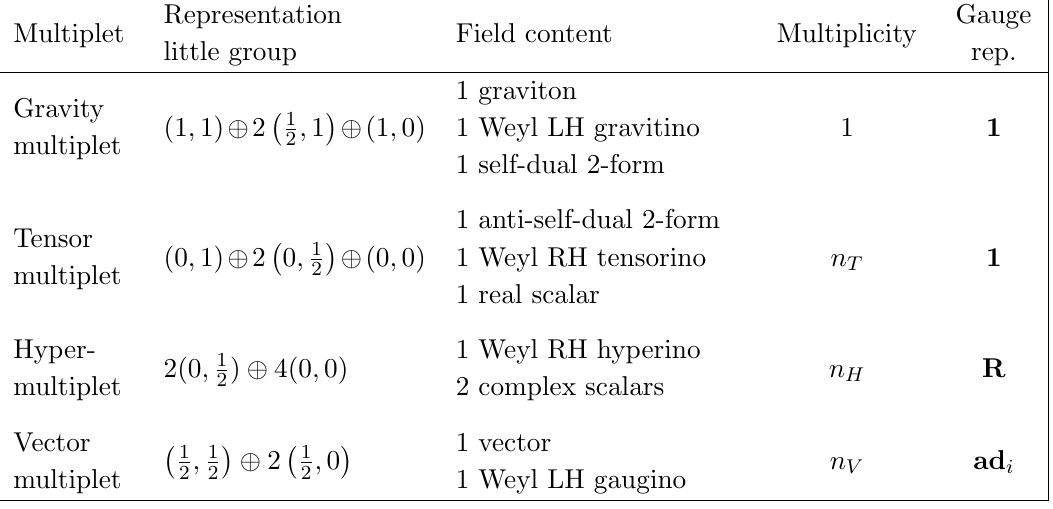
Table 2 . Field content of 6d = (1 ; 0) supergravity. We have used the shorthand RH and LH for N right- and